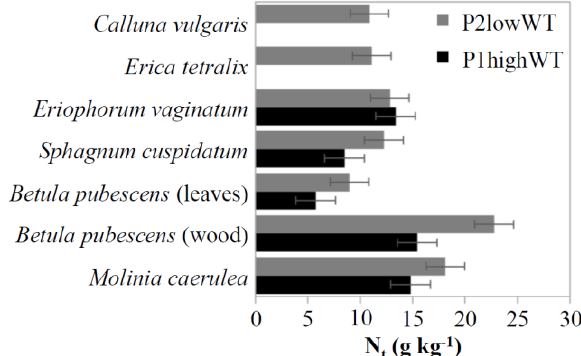
Figure 7. Total N content (dry mass basis) in single plant species. Whiskers indicate standard error. Calluna vulgaris and Erica tetralix did not occur at